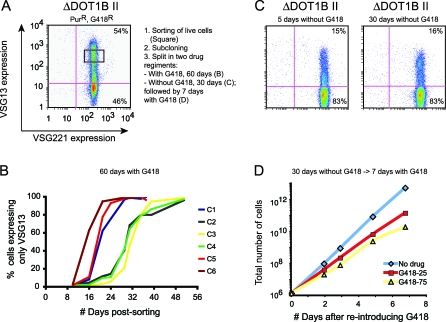
ΔDOT1B Double-Expressers Are Stable Switching Intermediates(A) A population of ΔDOT1B Class II cells brightly stained with anti-VSG221 and anti-VSG13 (square) was sorted and subcloned by limiting dilution either in the presence of 100 μg/ml G418 (60 d) or in the absence of any drug (30 d).(B) Six clones grown in the presence of G418 were submitted to FACS analysis every 8 d to follow the proportion of cells that exclusively express VSG13.(C) After 5 and 30 d without any antibiotics, VSG221 and VSG13 expression was measured by FACS. The profile of one representative clone is shown.(D) After 30 d without antibiotic, cells were diluted in 25 or 75 μg/ml G418, and cell growth was followed for 7 d.